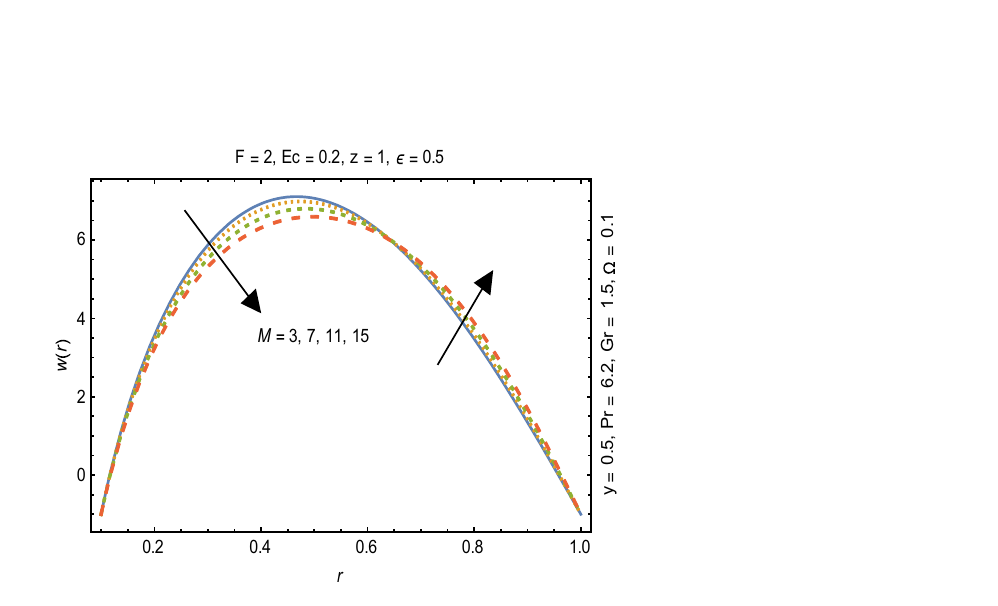
Figure 4. Variation in w(r) against